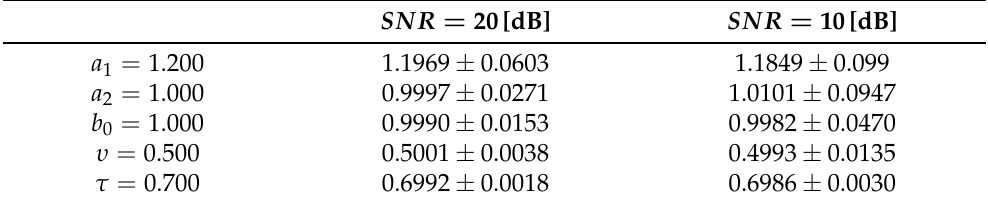
Table 3. Mean and standard deviation of the fractional model parameter estimates obtained by the